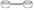
PP1 map generated by STRING showing the interactions of the selected 20 proteins Edges represent protein-protein associations,  interactions from experimentally determined,  text mining,  known interactions from curated databases,  gene fusions,  gene co-occurrence,  co-expression and  protein homology.